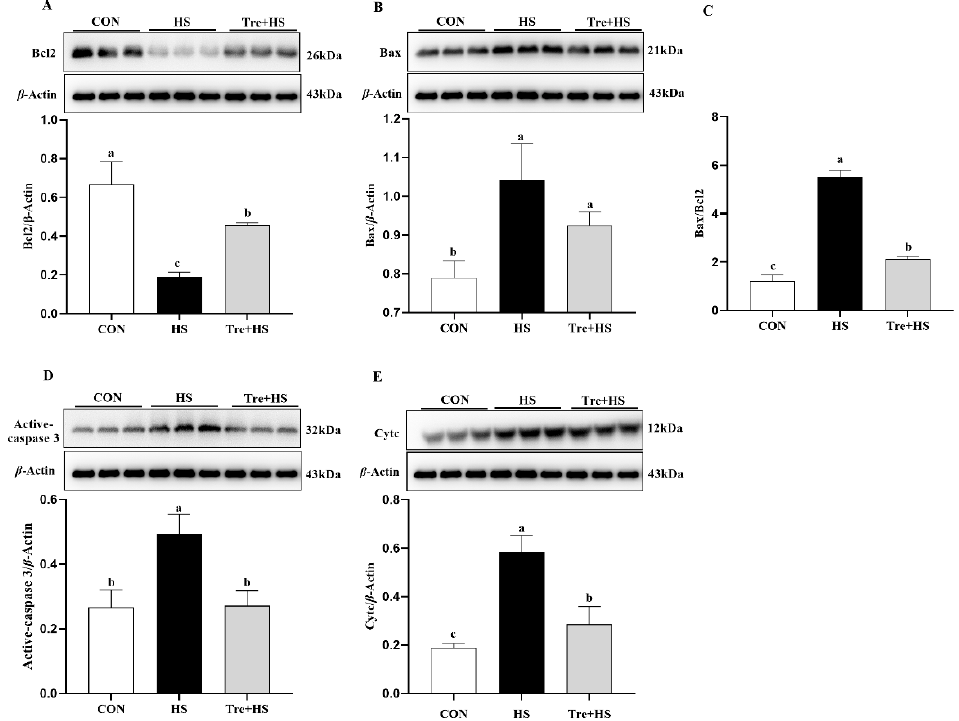
Figure 6. Effects of trehalose on protein expressions of apoptosis-related proteins in heat-stressed IPEC-J2 cells. IPEC-J2 cells were cultured at 37 ◦ C until the end of the experiment (control, CON); exposed to heat stress for 2 h (43 ◦ C, HS); or pretreated with 10 mM trehalose at 37 ◦ C for 4 h prior to heat stress exposure for 2 h (Tre + HS). Western blotting analysis of the expression of Bcl2 ( A ) Bax ( B ), Bax/Bcl2 ratio ( C ), active caspase 3, ( D ) and Cyt c ( E ). Bax: BCL2-associated X protein; Bcl2: B-cell CLL/lymphoma 2; active caspase 3: Active cysteine aspartate-specific protease 3; Cyt c: cytochrome c. Data are shown as mean ± SD (n = 3). Means for variables that do not share a common letter differ significantly ( p < 0.05).